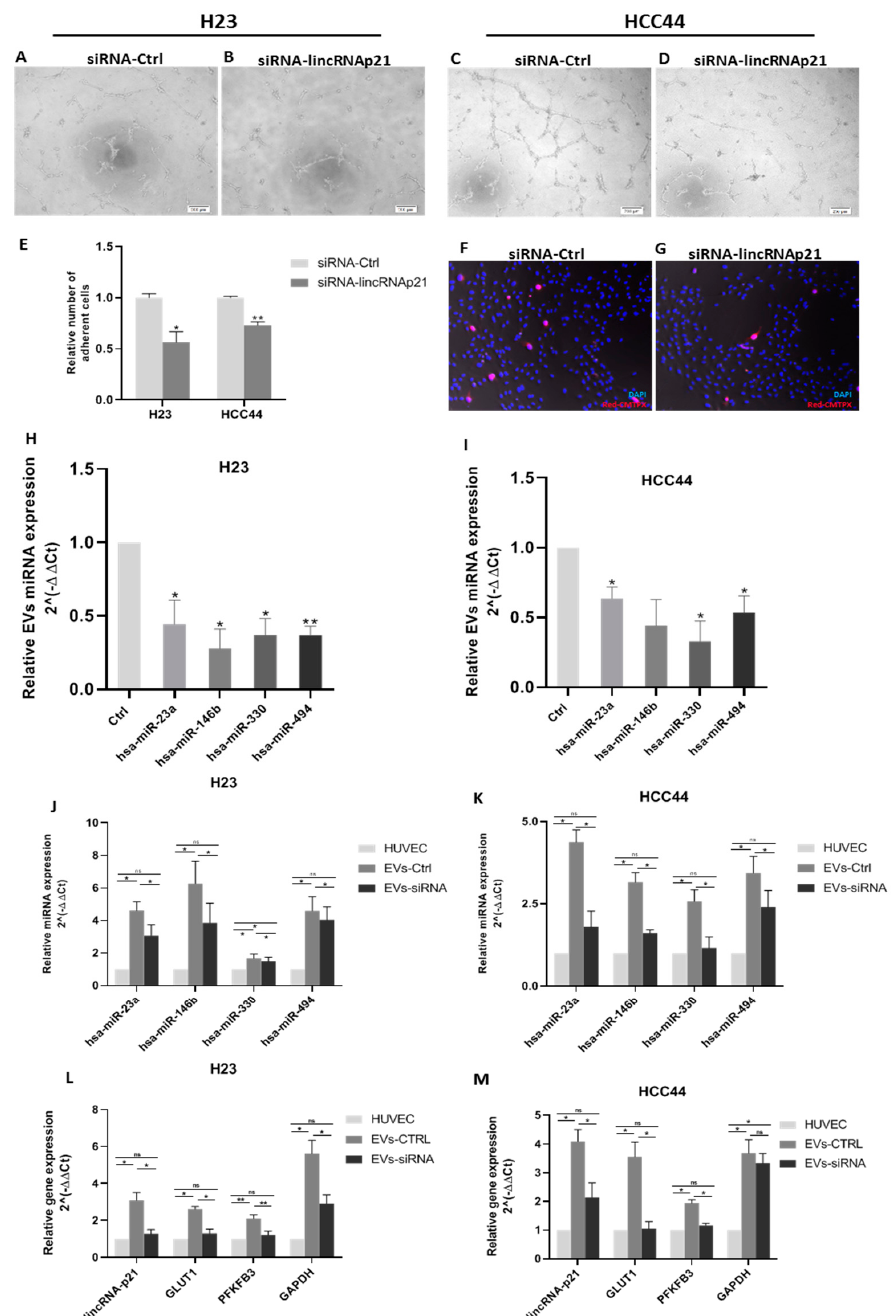
Figure 3. Functional in vitro assays to evaluate the modulation of angiogenesis and endothelial cell permeability by EV treatment. ( A – D ) Tube formation assay using human umbilical vein endothelial cells (HUVECs) treated with control EVs in H23 ( A ) and HCC44 ( C ) and lincRNA-p21-silenced EVs in H23 ( B ) and HCC44 ( D ). ( E ) Quantification of relative number of adherent cells in a cell adhesion assay using a monolayer of HUVECs treated for 12 h with control EVs or lincRNA-p21-silenced EVs. ( F , G ) A representative image of HCC44 cell adhesion assay. Blue staining using DAPI indicates nucleus and HCC44 cells were stained with cell tracker in red (20× magnification). ( H , I ) lincRNA-p21 silencing reduced the EV levels of miR-23a, miR-146b, miR-330, and miR-494 in both cell lines. ( J , K ) EV conditioning increases the expression of miR-23a, miR-146b, miR-330, and miR-494 in HUVECs. ( L , M ) EV conditioning increases the expression of lincRNA-p21, GLUT1 , PFKFB3 , and GAPDH in HUVECs. * p < 0.05; ** p < 0.01.